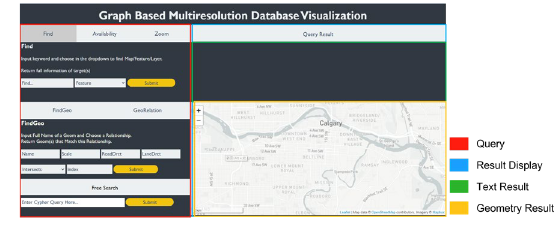
Figure 4 . Layout of